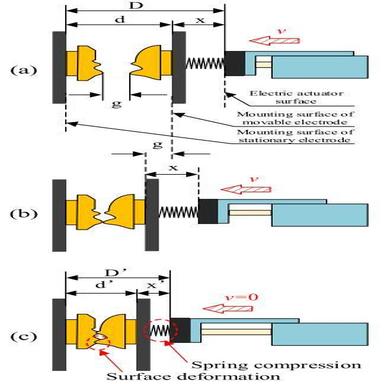
The schematic illustration of closing process. (a) Actuation rig in the opening state. (b) First touch between electrode pair. (c) Actuation rig in the closing state.